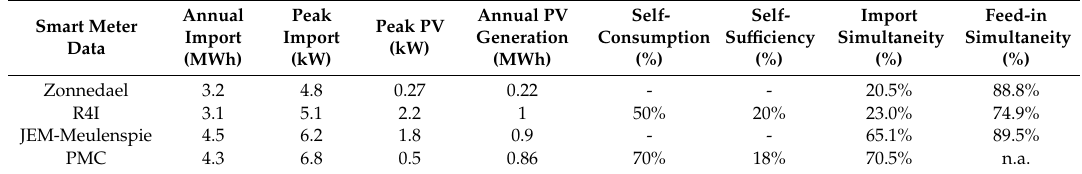
Table 3. Summary of the calculated key performance indicators in average values.